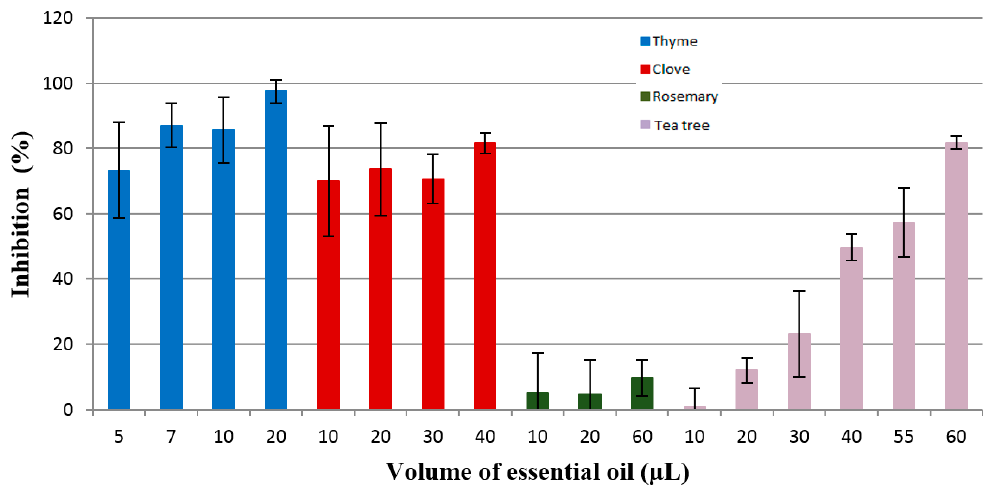
Figure 5. Inhibition of the Fusarium graminearum G87 growth by the thyme, clove, rosemary, and tea tree essential oils.